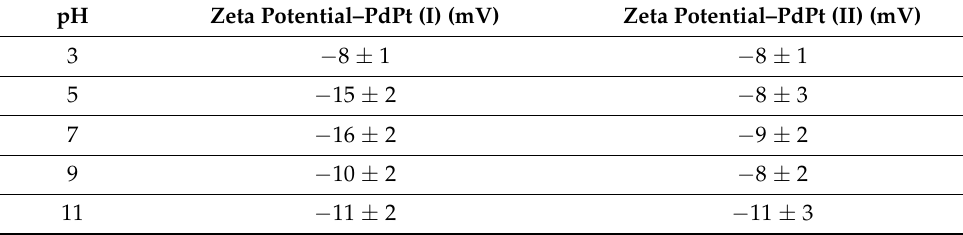
Table 1. Zeta potential values depending on pH for both types PdPt